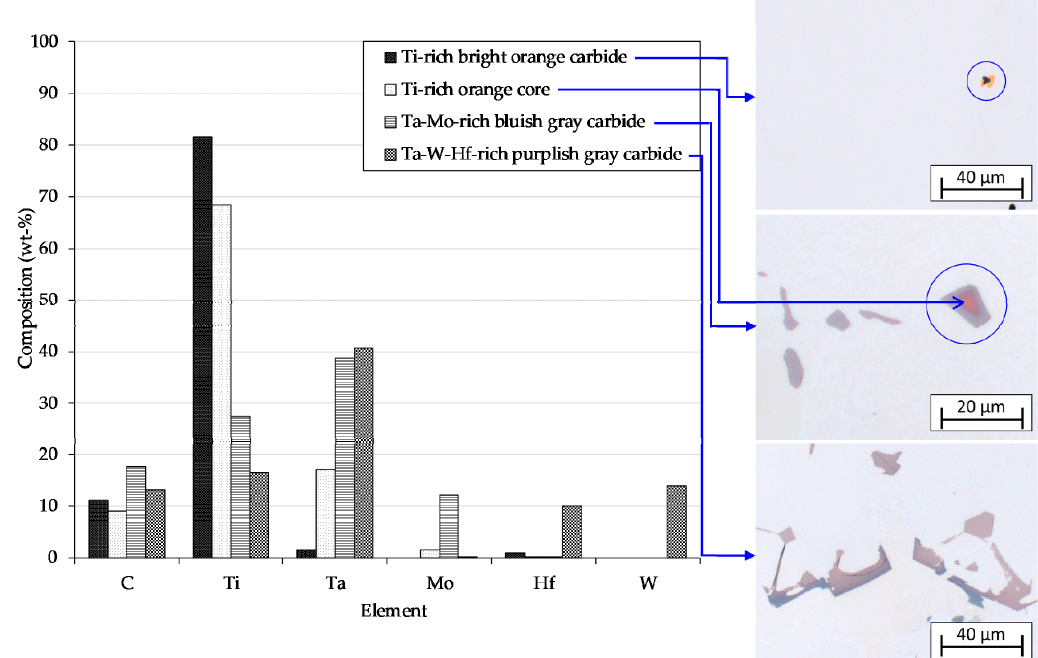
Figure 7. Chemical composition of various carbides observed in OM images of CMSX-6 (W4, upper), CMSX-6 (W1, middle) and MAR-M247 (W1, lower).